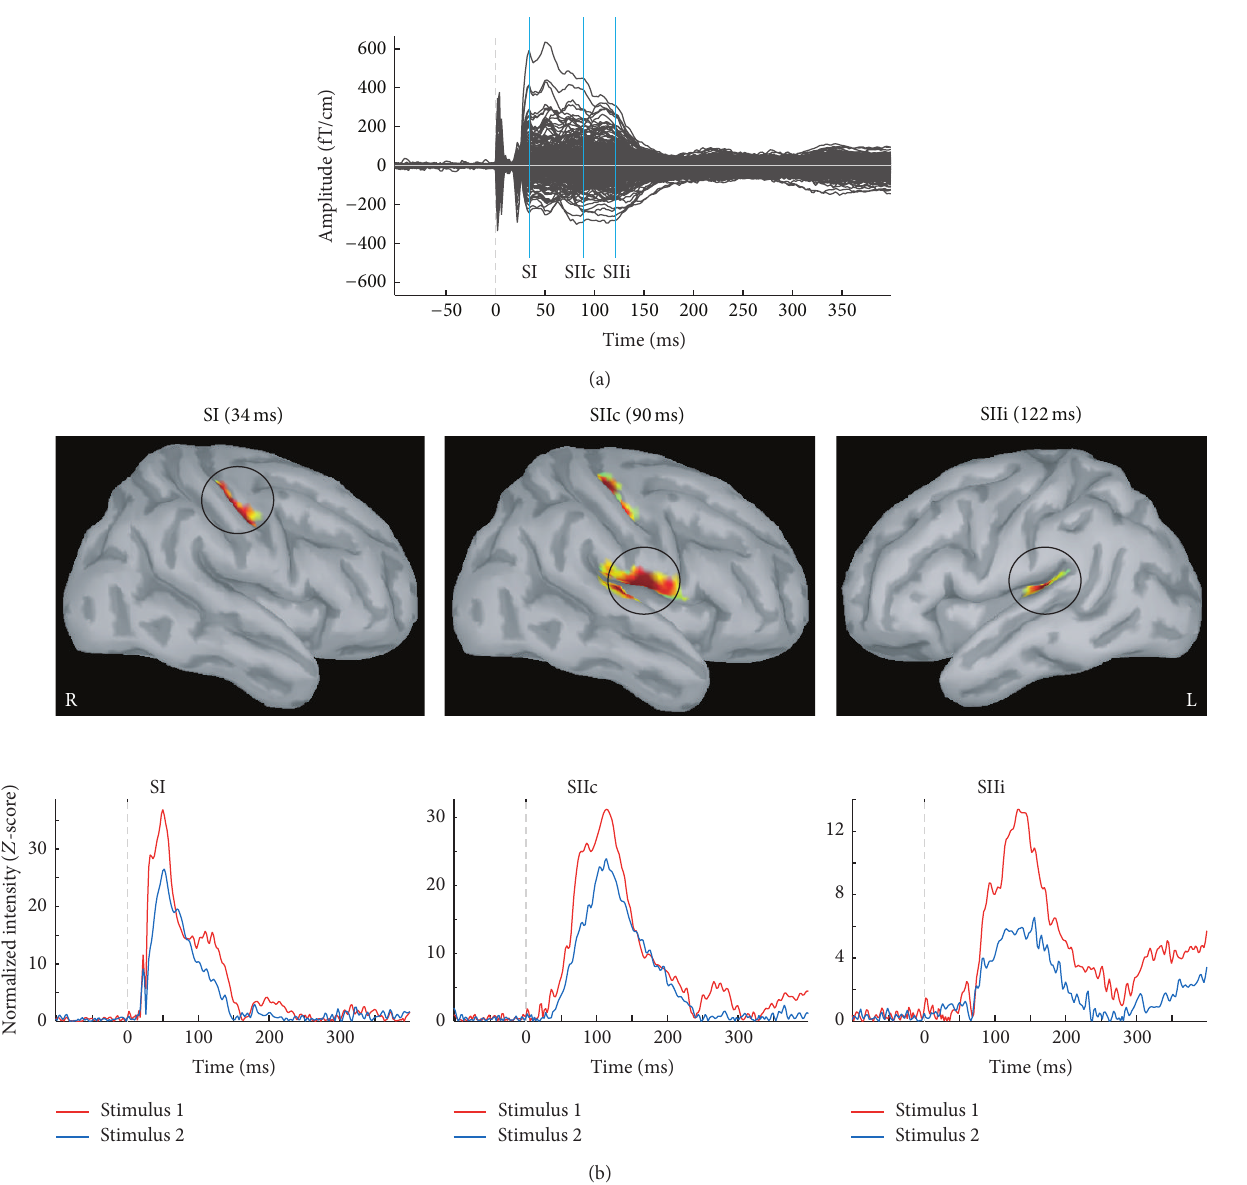
Figure 1: (a) Somatosensory evoked fields to electrical stimulus 1 in one young representative subject. The early primary somatosensory response (SI) is followed by longer latency contralateral (SIIc) and ipsilateral (SIIi) secondary somatosensory responses. (b) Upper panel: three regions of interest (ROIs, 4 to 5 cm 2 ) on the Montreal Neurological Institute Colin27 brain template; lower panel: the temporal dynamics of the minimum norm estimate (MNE) in response to stimulus 1 and stimulus 2 are extracted from the selected